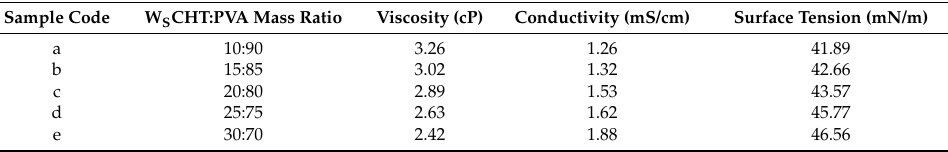
Table 1. Properties of